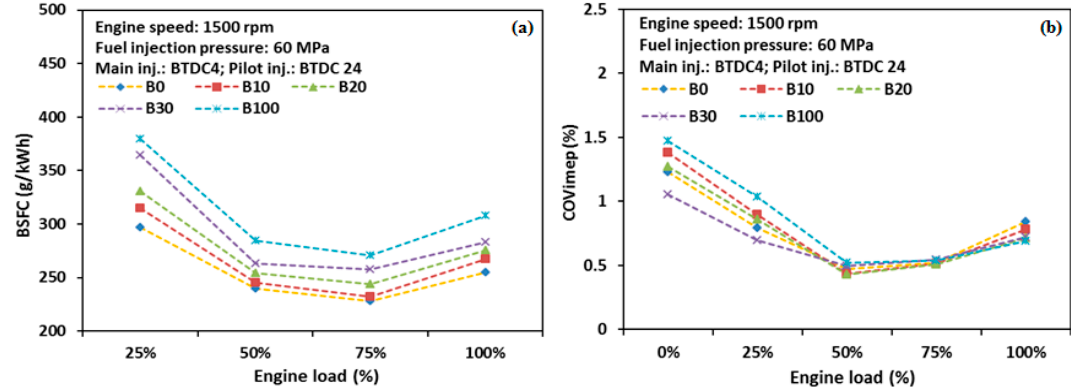
Figure 5. Variation of ( a ) brake specific fuel consumption (BSFC) and ( b ) the coefficient of variation of the indicated mean effective pressure (COVimep) for various biodiesel blends.